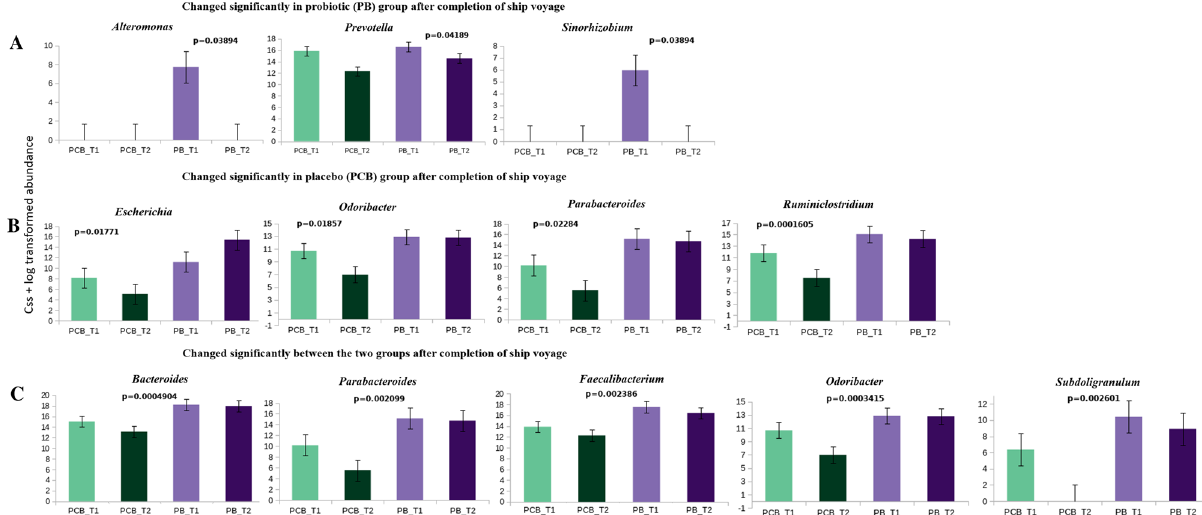
Figure 2. Taxonomic composition (css + log transformed) at genus level. A - At baseline, the genus did not have a significant difference between PCB and PB groups, but changed significantly in the PB group at the end of ship voyage. B - The genus changed significantly only in PCB group during the ship voyage. C - The genus abundance changed significantly between PCB and PB groups after completion of the ship voyage (PCB_T2 and PB_T2). p -value < 0.05 was considered to be statistically significant (Wilcoxon rank-sum tests) using in-house R-script. Error bar represent standard error mean